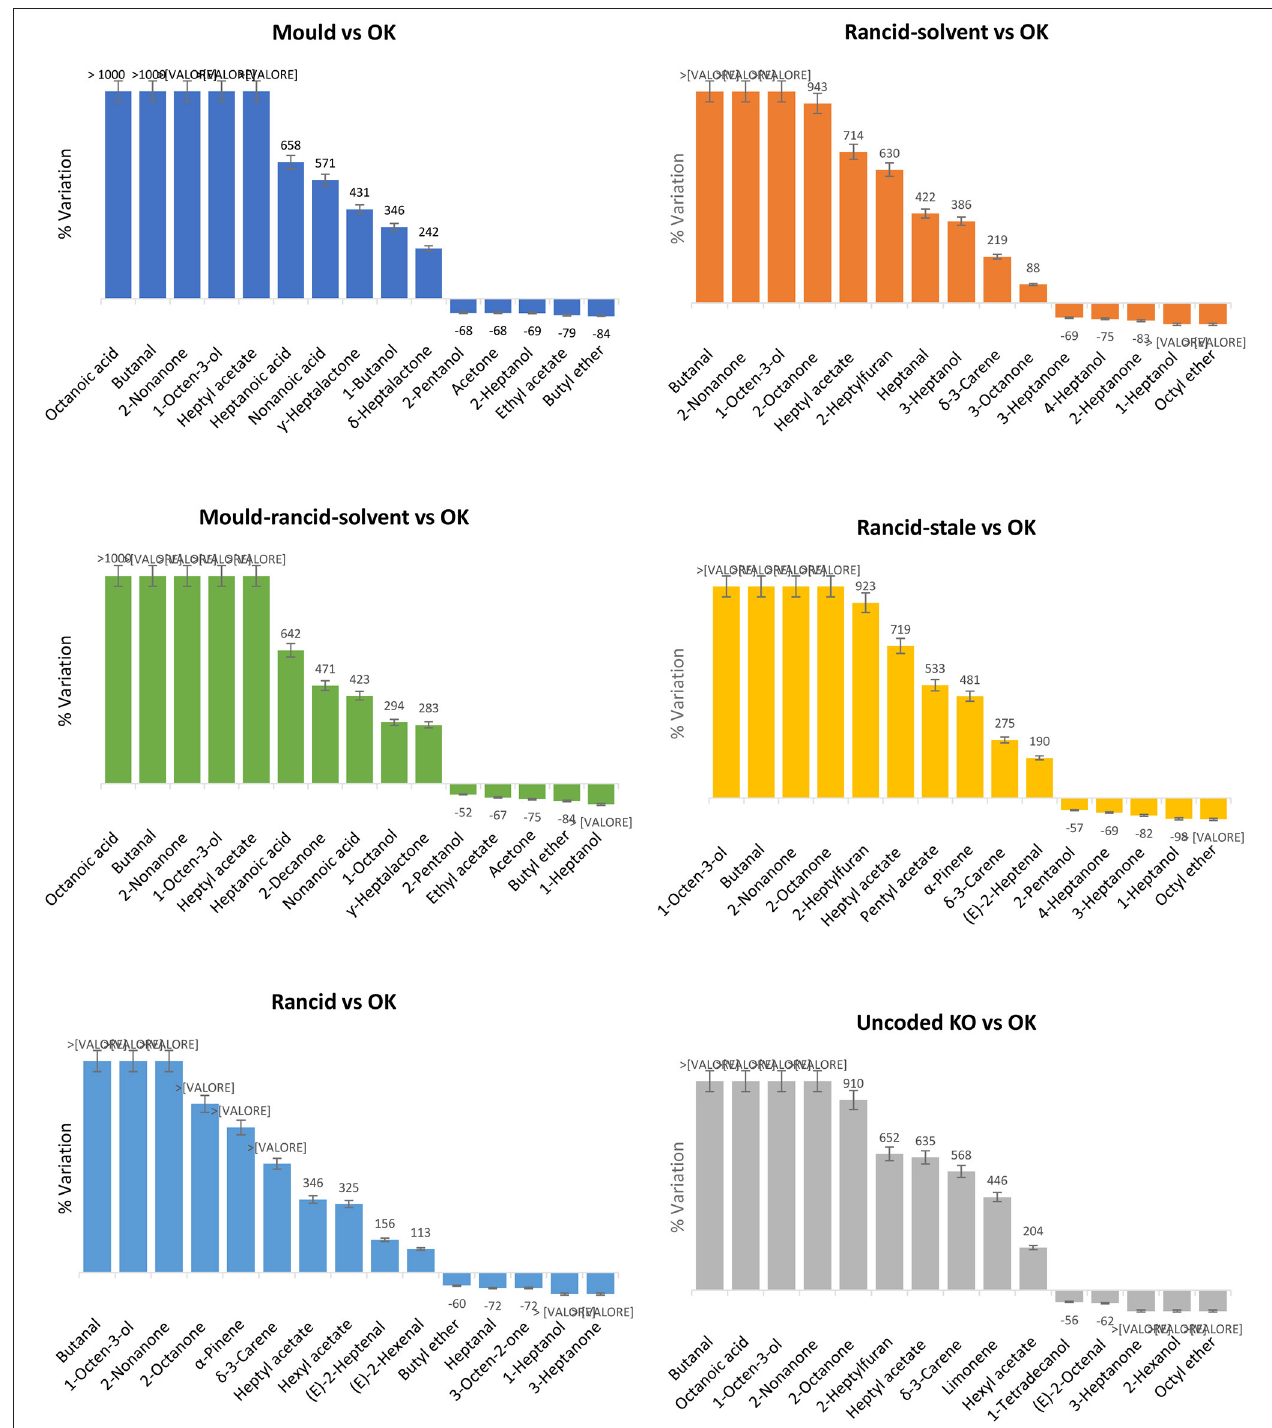
FIGURE 2 | Histograms illustrating the % response ratios for analytes with larger variation between spoiled hazelnuts class-image pairs. OK samples are adopted as reference classes for comparisons. Error bars correspond to ± SD over analytical replicates. tissue necrosis and decreasing the overall quality of the Another critical defect is associated with the bug hazelnut kernel due to off-flavors and bitterness (Singldinger damage, by species like Palomena prasina L., Gonocerus acuteangulatus G., and Piezodorus lituratus F., determining et al., 2018). Singldinger et al. (2018) identified, through a